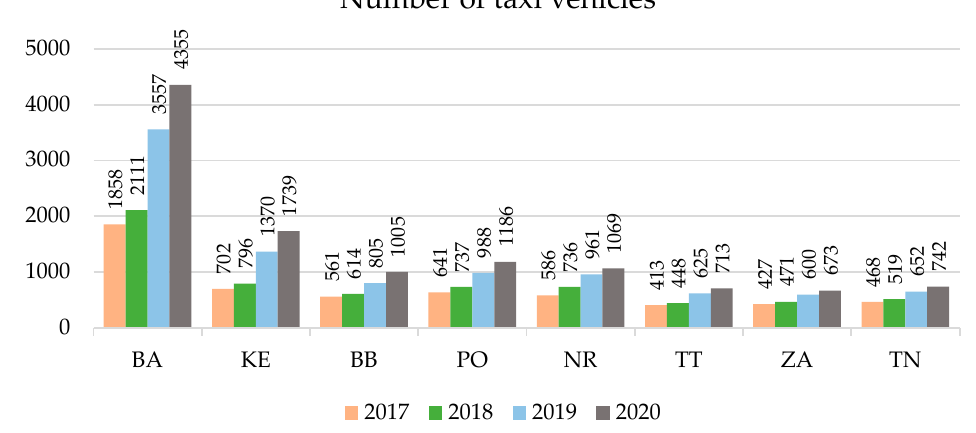
Figure 2. Registered taxi vehicles in Slovak regions. Abbreviations of regions: Bratislava (BA), Košice (KE), Prešov (PO), Banská Bystrica (BB), Nitra (NR), Trnava (TT), Žilina (ZA) and Tren č ín (TN).